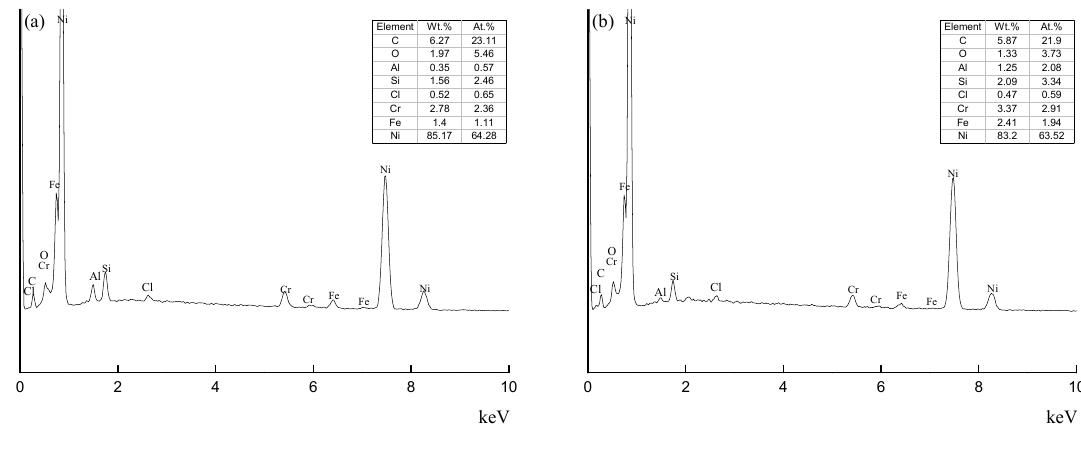
Figure 10. EDS results for area A ( a ) and area B ( b ).